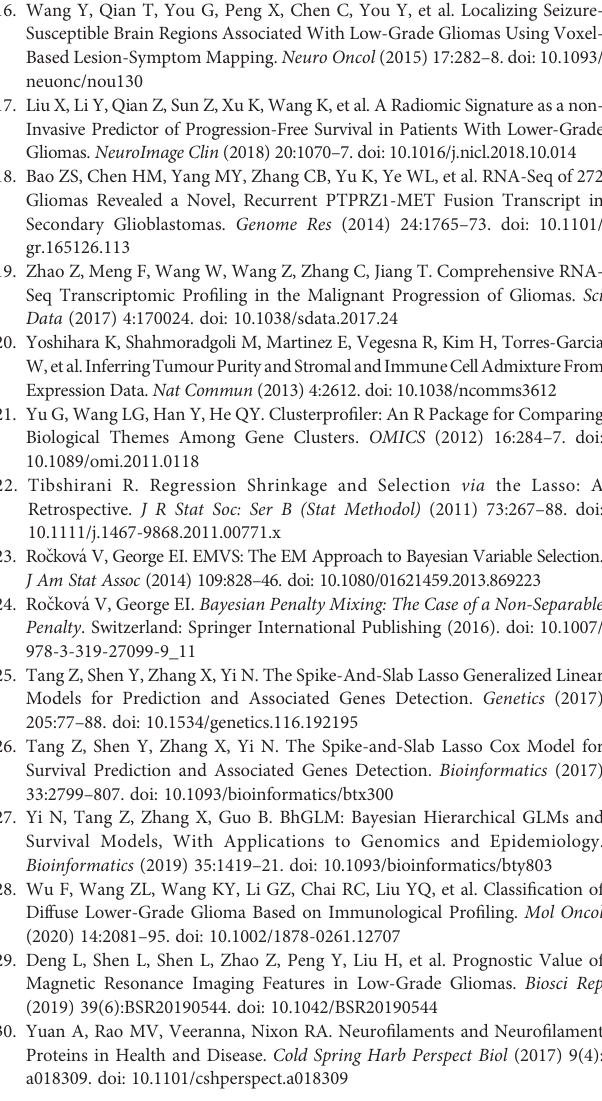
regression in TCGA(PFS). (C) Forest plots of univariate Cox regression in CGGA693. (D) Forest plots of univariate Cox regression in CGGA325. Supplementary Figure 4 | (A) Kaplan – Meier curves for the low riskscore group and high riskscore group in patients with radiotherapy and patients did not receive radiotherapy in model1. (B) Kaplan – Meier curves for the low riskscore group and high riskscore group in patients with radiotherapy and patients did not receive radiotherapy in model2. Supplementary Table 1 | Basic patient characteristics in TCGA dataset. Supplementary Table 2 | Basic patient characteristics in CGGA693 and CGGA325